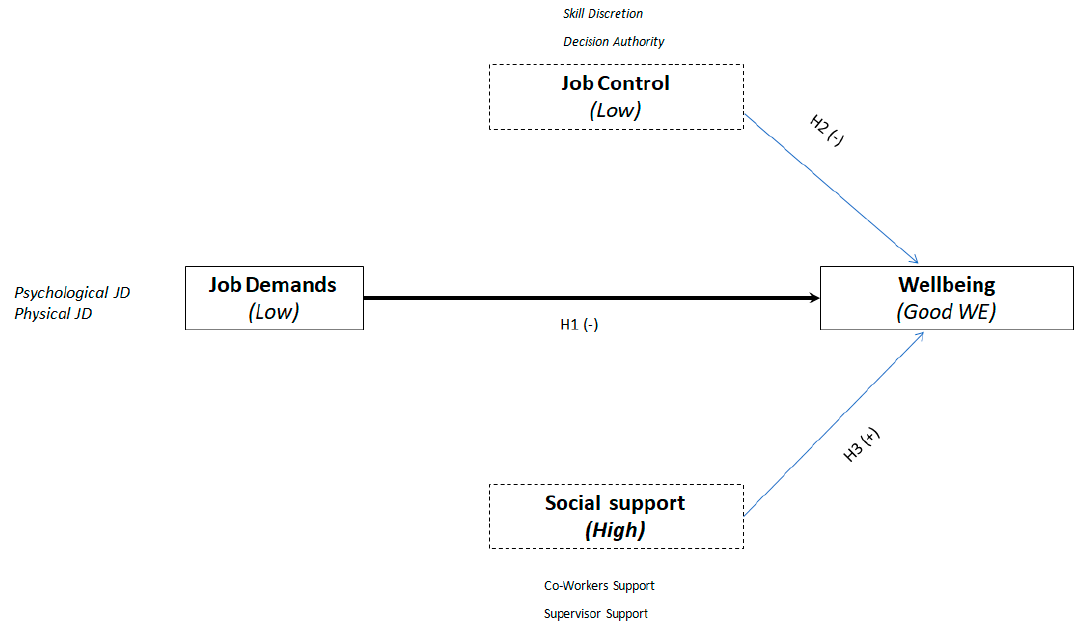
Figure 1. Research model. Source: prepared by the authors.